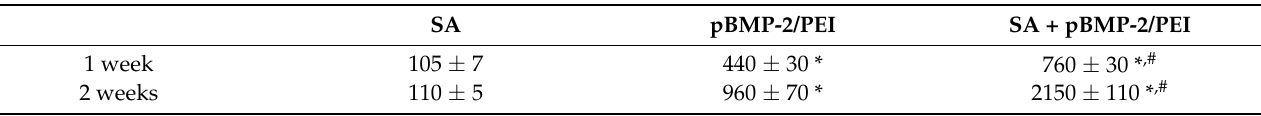
Table 1. BMP-2 abundance level (pg/mL) in the culture supernatant when incubating MSCs with gene-activated scaffolds for 1 and 2 weeks. ELISA.